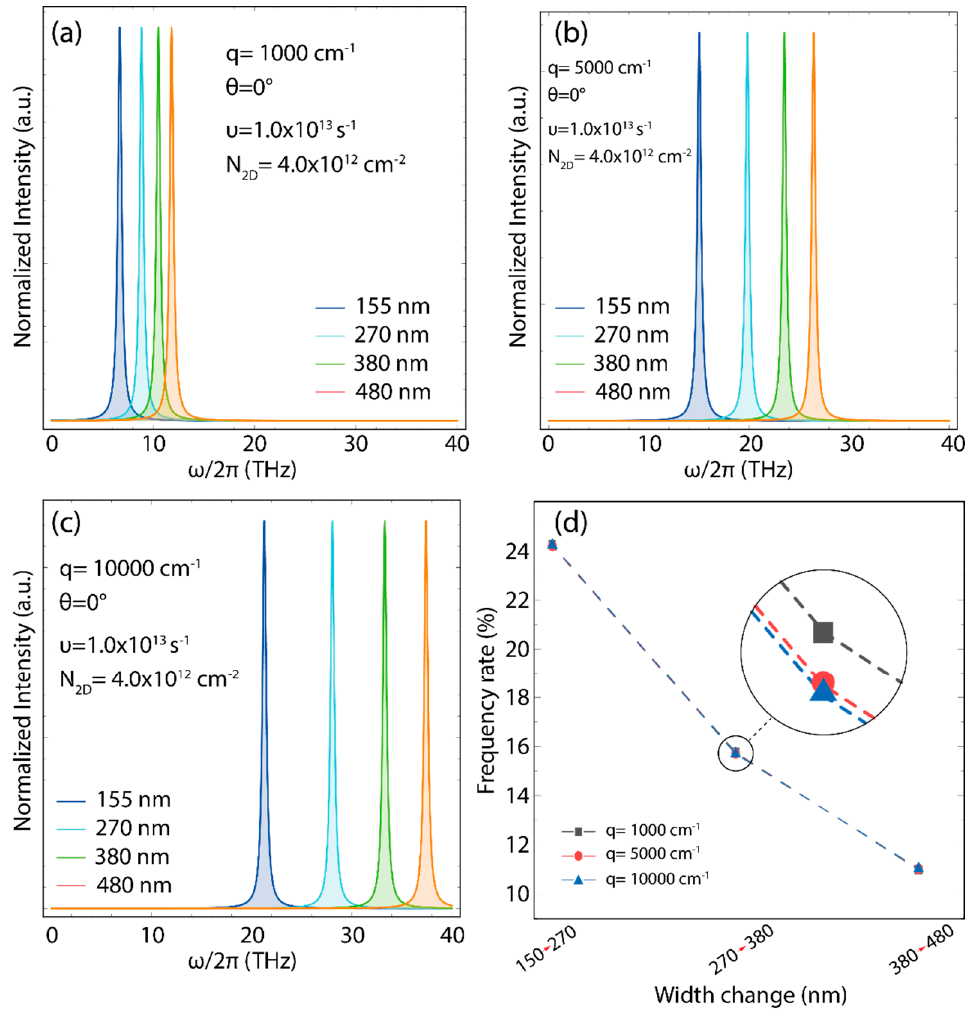
Figure 15. Plasmon excitation lifetime ( ≤ 40 THz) at ( a ) q = 1000 cm − 1 , ( b ) q = 5000 cm − 1 , ( c ) q = 10,000 cm − 1 ; considering different ribbons widths (155, 270, 380, and 480 nm). ( d ) Percentage variation in plasmon frequency by increasing ribbon width for three different q values ( q = 1000, 5000, 10,000 cm − 1 ). The parameters of Equation (4) have been fixed as: N 2 D = 1.0 × 10 12 cm − 2 , θ = 0, ν = 4.0 × 10 13 s − 1 , and v F = 0.829 × 10 6 m s − 1 . The plasmon spectra were calculated using Lorentzian shape function to a maximum value of 1 with FWHM = 0.25 .